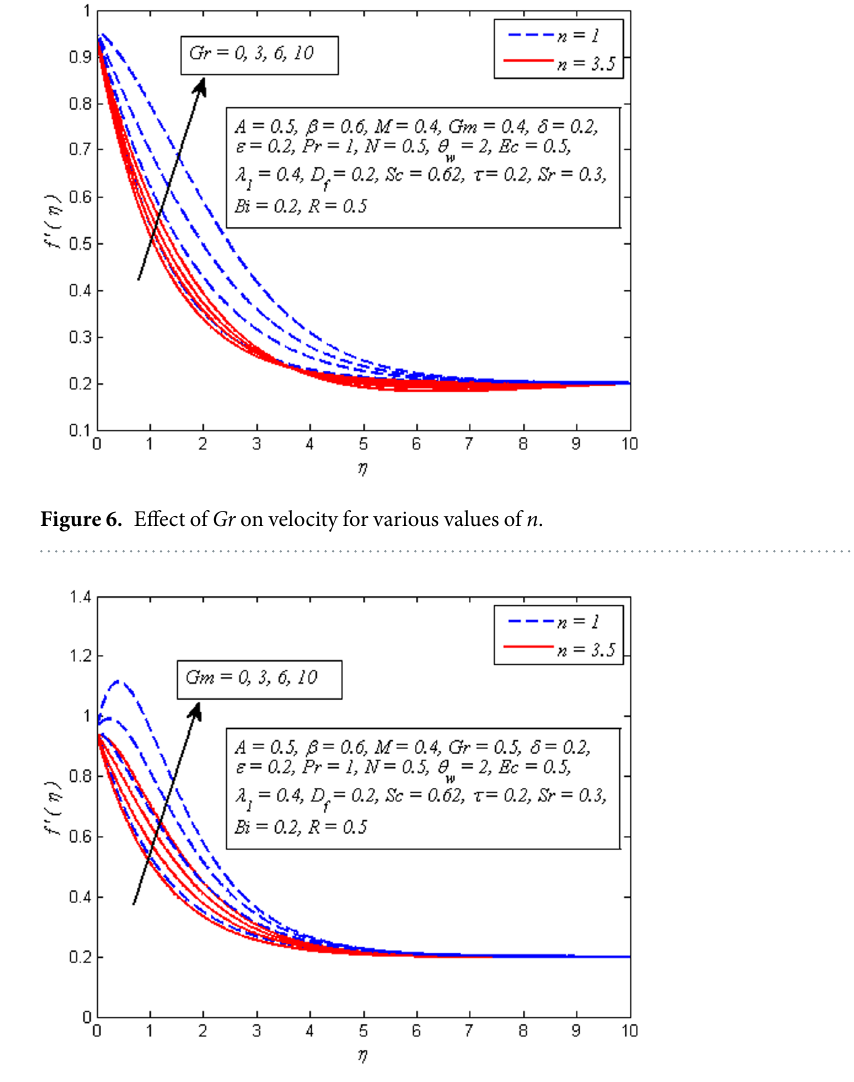
Figure 7. Effect of Gm on velocity for two different values of n .